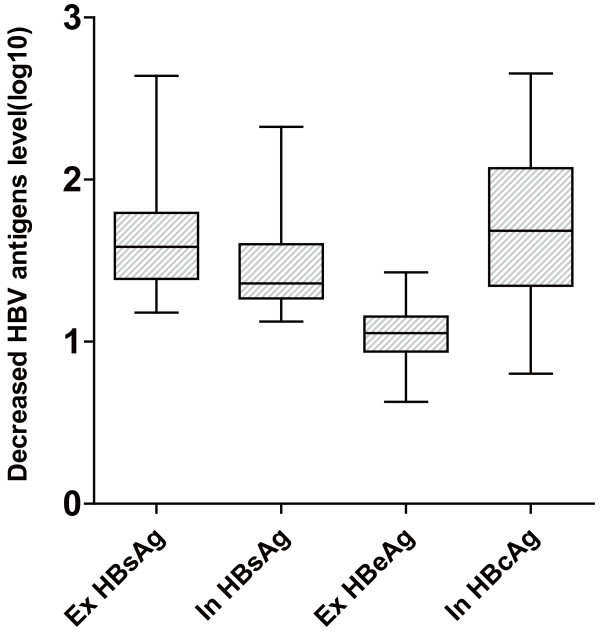
Comparing the RNAi-induced silencing effect on different viral markers. Data were displayed the average antigen level of the 4 siRNAs reduced for five HBV strains. "Ex" = Extracellular and "In" = Intracellular. The Mann-Whitney test was used to assess the difference. An asterisk represents a statistical difference of P < 0.01 in comparison with the other markers (Ex HBeAg vs. Others P < 0.001, Ex HBsAg vs. In HBsAg P = 0.05, Ex HBsAg vs. In HBcAg P = 0.82, In HBsAg vs. In HBcAg P = 0.10.)